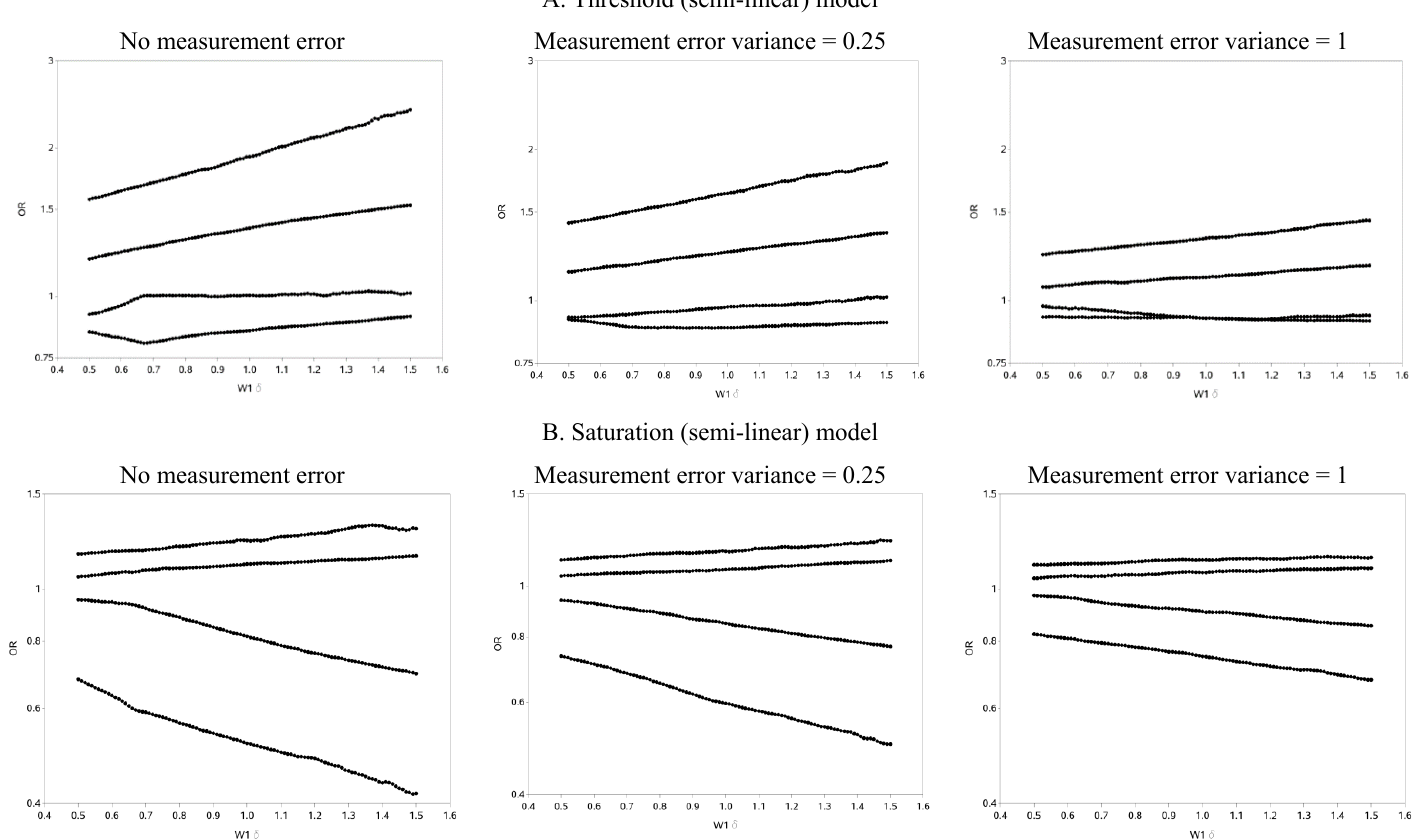
Figure A3. Odds ratios (OR) for different cutoffs used to create 5 categories for mismeasured exposure (W 1 ), 101 cutoffs, with the true “weak” association. The 4 W1 cutoffs were centered at 0 with δ from 0.5 to 1.5 standard deviations, in increments of 0.1. Reference category for W1 is mean +/−(0.5 × δ × standard